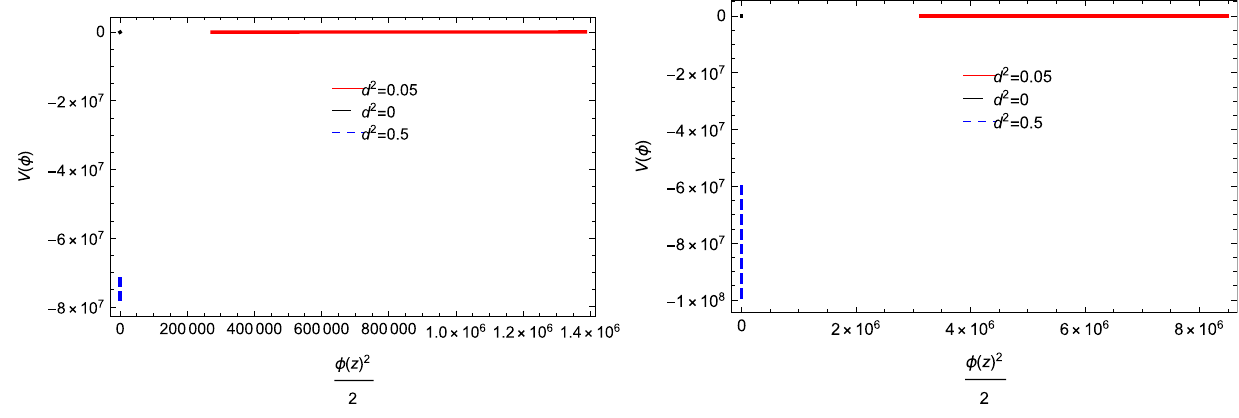
Fig. 27 Plot of φ verses V for u = 1 and u = 2 . 002 for K-essence scalar field model